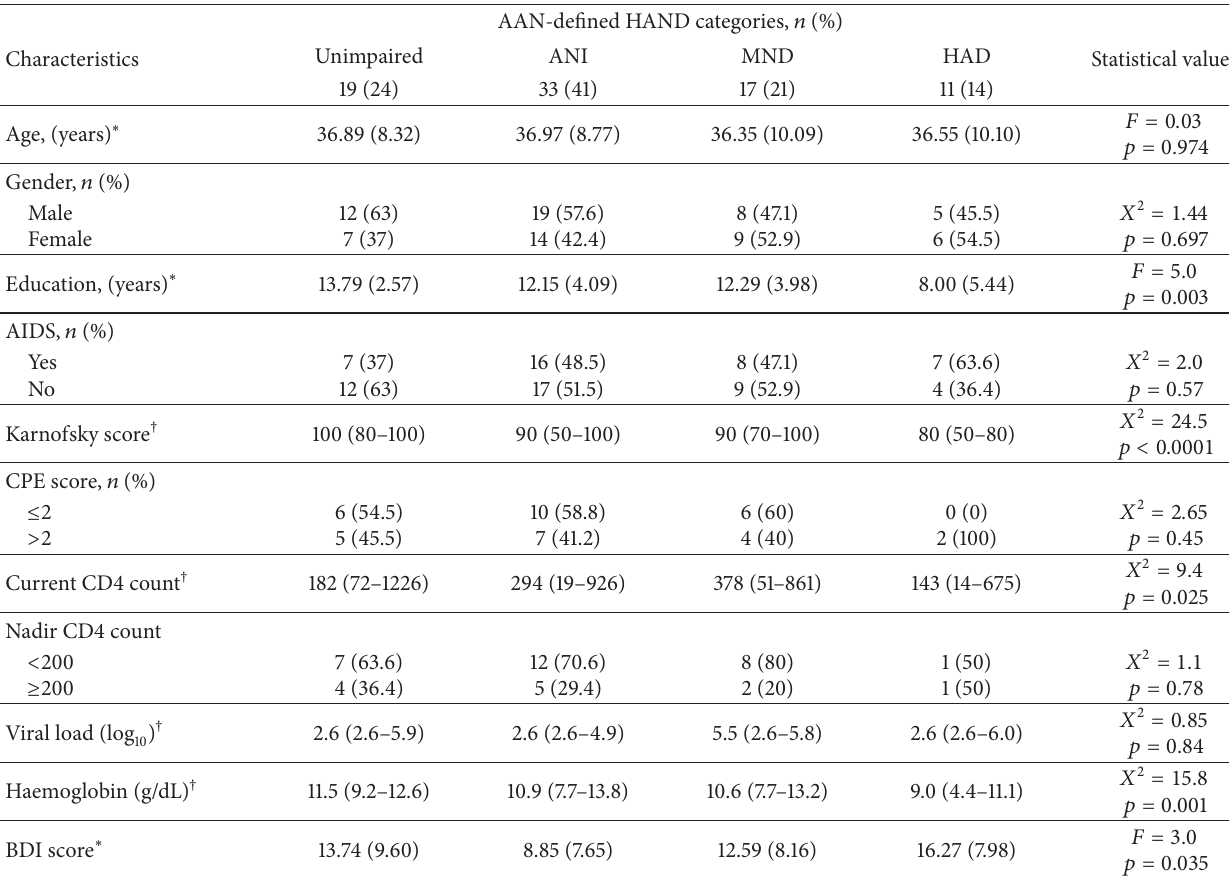
Table 3: Demographic, clinical, and laboratory characteristics of HIV-positive individuals across the HAND categories.